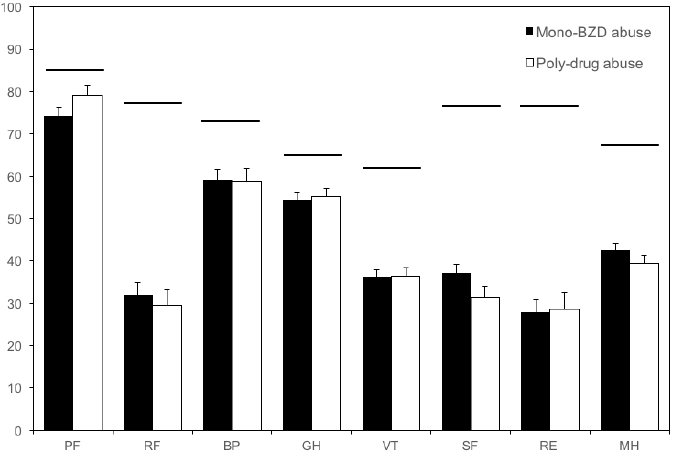
Figure 1. Score in the SF-36 dimensions. Closed bars: mono-BZD misusers (either one or more BZDs, n = 166); open bars: poly-drug misusers ( n = 101). The SF-36 scores ranged from 0 (worst score) to 100 (best score). None of the dimensions significantly differed between the two groups. Horizontal bars indicate the mean score in the Italian population [8,24]. Vertical error bars equal one SEM. BP: Bodily pain; BZD: Benzodiazepine; GH: General health; MH: Mental health; PF: Physical functioning; RE: Role emotional; RF: Role physical; SF: Social functioning; SF-36: Short Form-36; VT: Vitality.